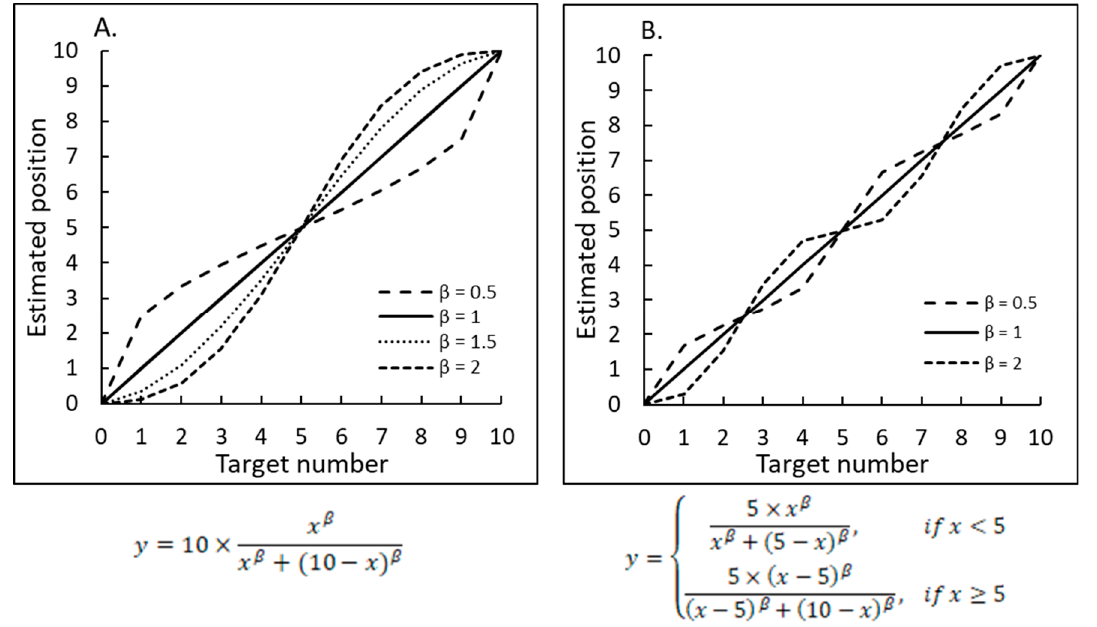
Figure 2. A representative schematic of curves fitting the estimated number position according to the proportion judgment model [12,13]. The shape of the curve depends on the value of β . ( A ) The curve fits the estimated number position when using numbers on the edges as anchors. ( B ) The curve fits the estimated number position when using the midpoint as an additional anchor point.